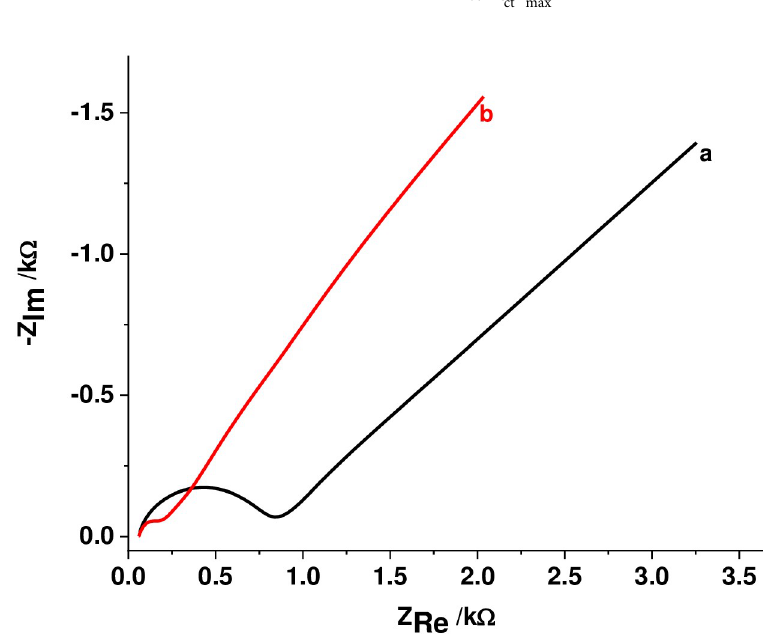
Fig 3. Nyquist plots for (a) bare GCE and (b) PARS/GCE in pH 7.0 PBS containing 10.0 mM [Fe(CN) 6 ] 3-/4- and 0.1 M KCl at frequency range: 0.01–100,000 Hz, applied potential: +0.23 V, and amplitude: 0.01